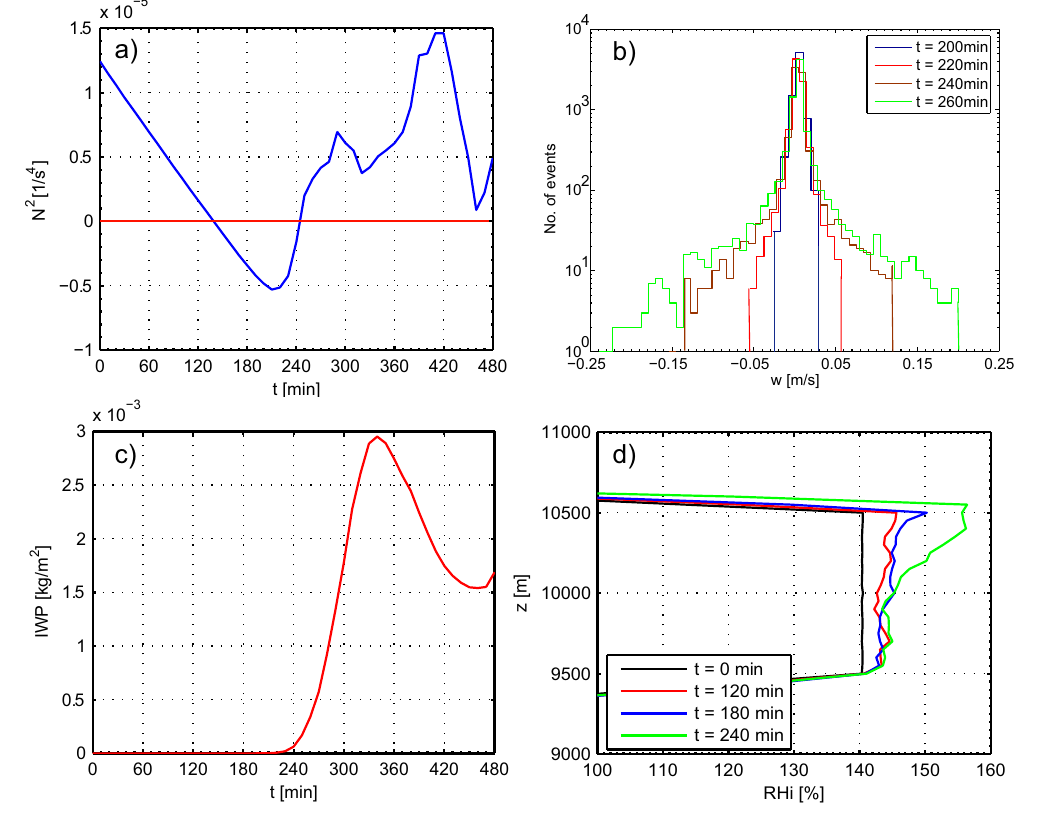
Fig. 4. (a) Time evolution of horizontal mean of the squared Brunt-Vaisala frequency at z = 10500m (altitude of maximum cooling); (b) His- togram: vertical velocity for 4 different timesteps (200 / 220 / 240 / 260min); (c) Time evolution of mean ice water path (IWP); (d) Maximum RHi for 4 different timesteps (0 / 120 / 180 /